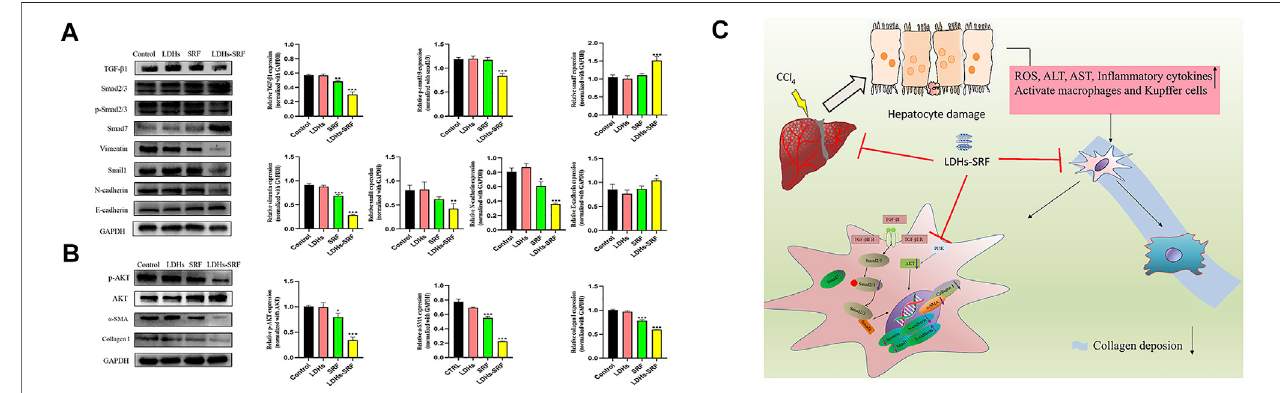
FIGURE 5 | Effects of LDHs-SRF on HSC-T6 through TGF- β 1/Smad EMT and AKT signaling pathway. (A) TGF- β 1/Smad/EMT signaling pathways, showing representative western blot and quantitative analysis graphs for TGF- β 1, Smad2/3, p-Smad2/3, Vimentin, Snail1, N-cadherin, E-cadherin; (B) AKT signaling pathway, showingrepresentativeimmunoblotsandquantitativeanalysisgraphsforp-AKT, AKT, α -SMA,CollagenI; (C) Schematicdiagramofthemolecular mechanismofLDHs- SRF in HSC-T6 cells. Data represent mean ± SD ( n = 3) and use one-way ANOVA with Tukey ’ s multiple comparison test, * p < 0.05, ** p < 0.01, *** p < 0.001 vs.